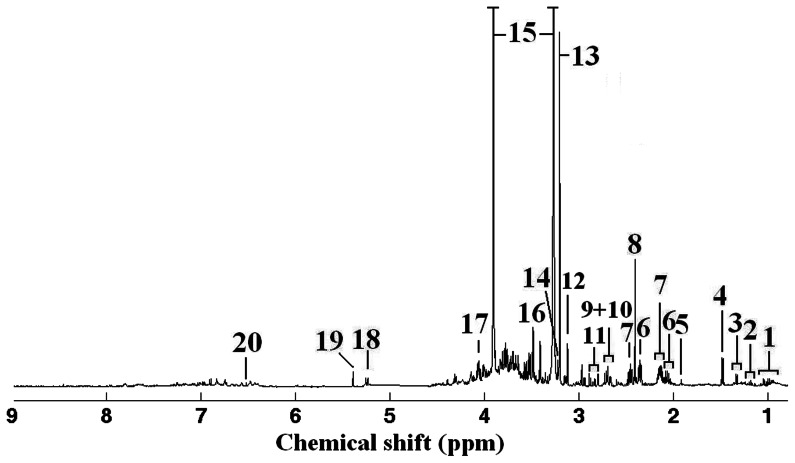
One representative 1-dimensional 500 MHz 1H NMR spectrum of metabolite extracts of the leaf tissue from S.
salsa in control group using extraction solvent system of methanol/water (1/1).Metabolite assignments: (1) branched chain amino acids: leucine, isoleucine and valine, (2) ethanol, (3) threonine, (4) alanine, (5) acetate, (6) glutamate, (7) glutamine, (8) succinate, (9) malate, (10) aspartate, (11) asparagine, (12) malonate, (13) choline, (14) phosphocholine, (15) betaine, (16) glycine, (17) fructose, (18) glucose, (19) unknown (5.39 ppm) and (20) fumarate.